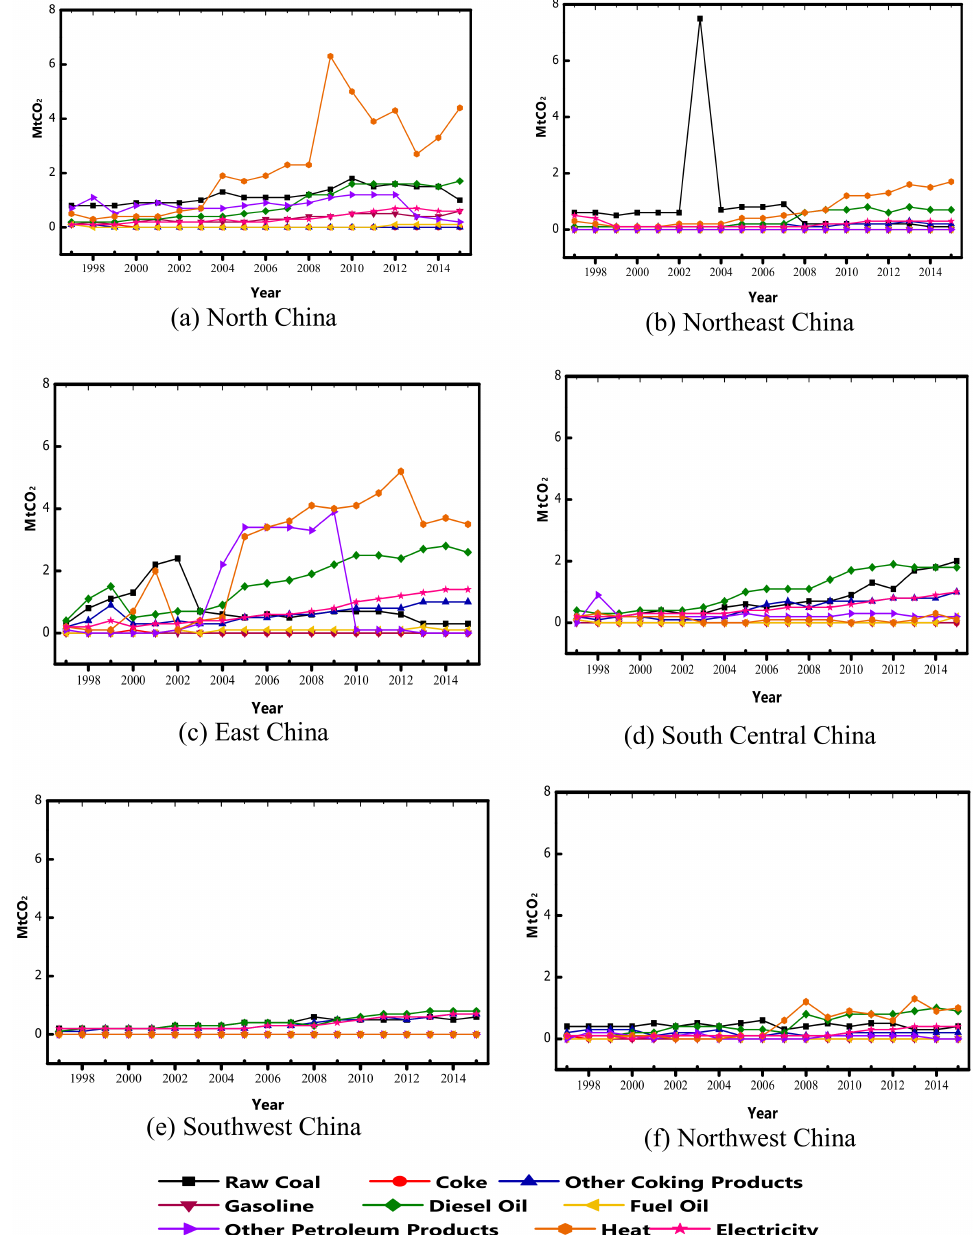
Figure 5. Energy sources of direct CO 2 emissions in the regional construction industries of